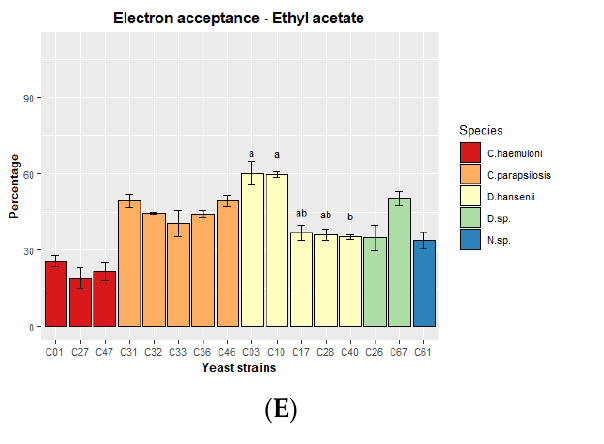
Figure 2. Different in vitro properties of the 16 yeast strains. ( A ) Biomass production (dry weight), ( B ) biofilm production, ( C ) autoaggregation at 1 h, ( D ) hydrophobicity, ( E ) electron acceptance, and ( F ) electron donation. The results are presented as the mean ± standard error. Different letters indicate significant differences ( p < 0.05) between yeast strains of the same species. The dash line indicates the arbitrary criteria for the selection of yeasts.